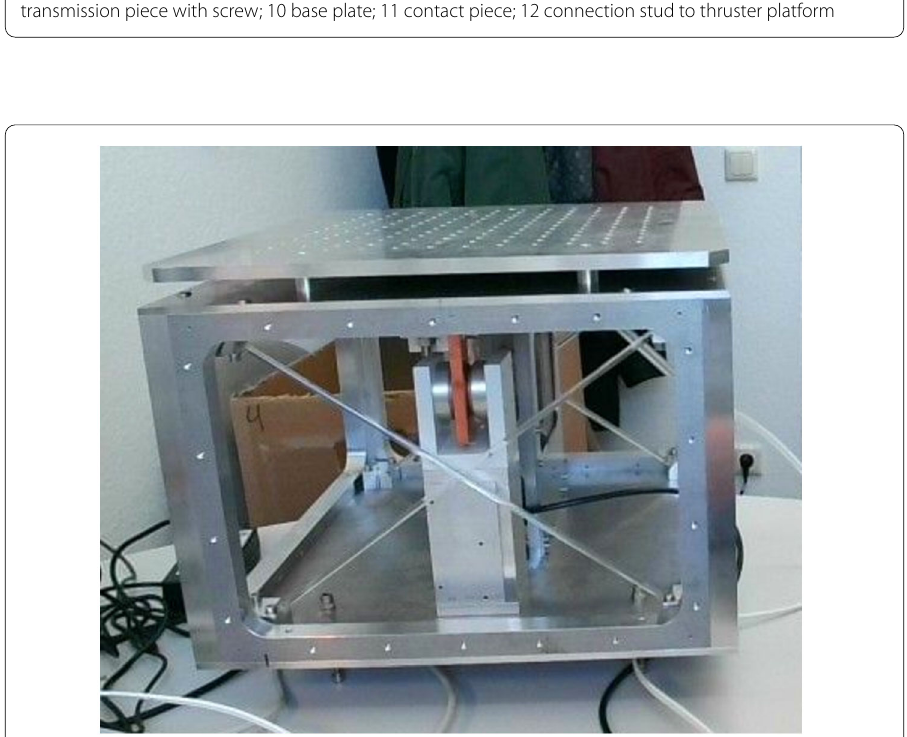
Figure 7 Open DEPB thrust stand. One can see some of the quartz rods holding the top thrust platform. Here, the eddy current brake is mounted: copper plate between two